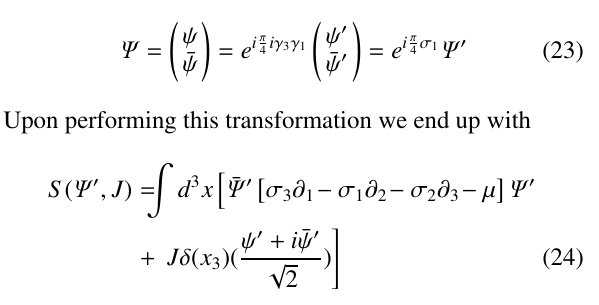
we rotate the three dimensional spacetime by − π the x 2 axis to obtain the view shown in the right half of Figure 2. The points carry the same labels as before but the spinor undergoes a